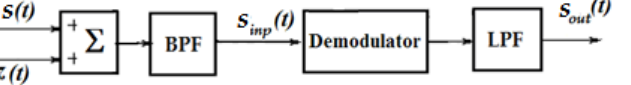
Figure 2. Equivalent scheme for demodulation analysis in the presence of noise.